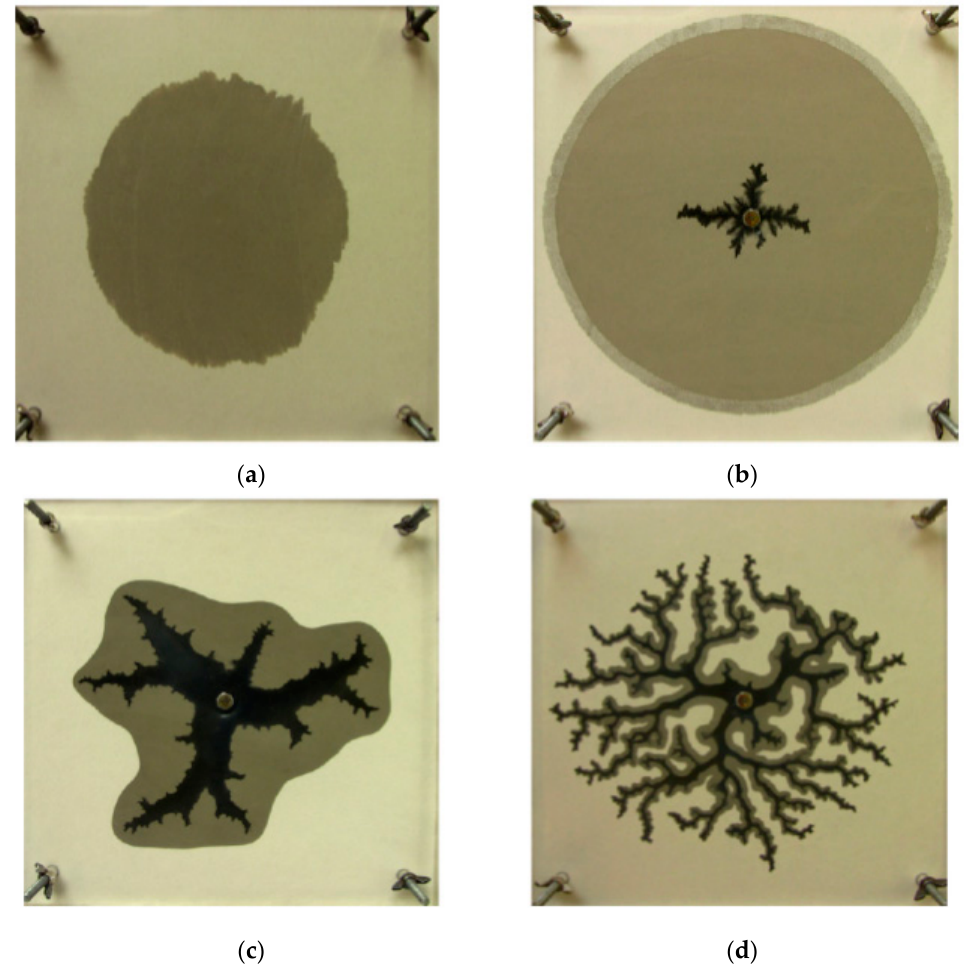
Figure 7. Schematic diagram of hydraulic dilatancy process. ( a ) Treatment of pre-dilatancy. ( b ) Formation of dilatancy area. ( c ) Extension of dilatancy area. ( d ) Dilatancy of large volume.